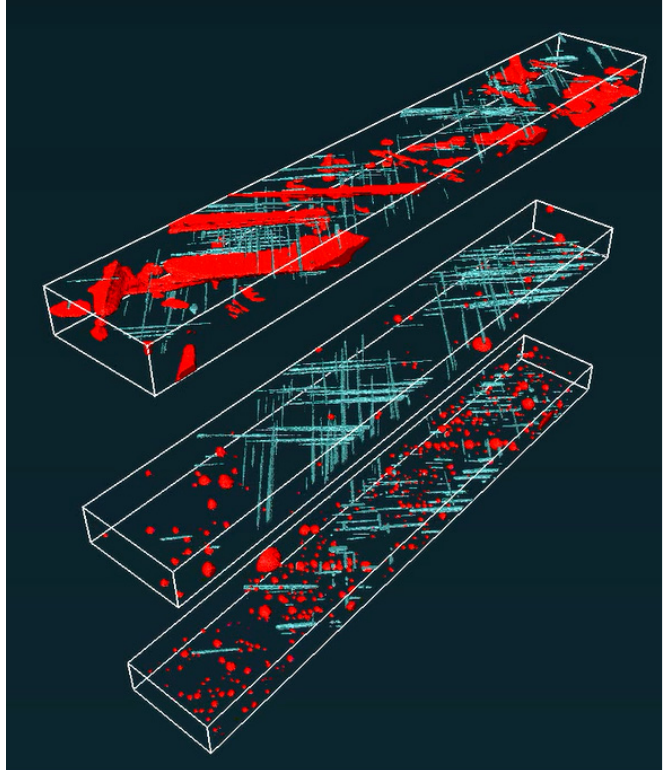
Figure 12. Voids in resin (red) versus voids near fibers (blue), for vacuum repair with hand layup (V1), hand layup lamination (HL), and UV curing handheld (UV1).